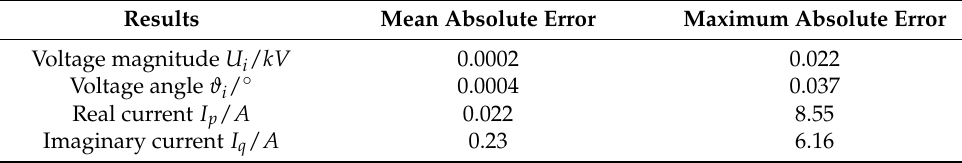
Table 5. Comparison of the linearized LFC with the Newton–Raphson